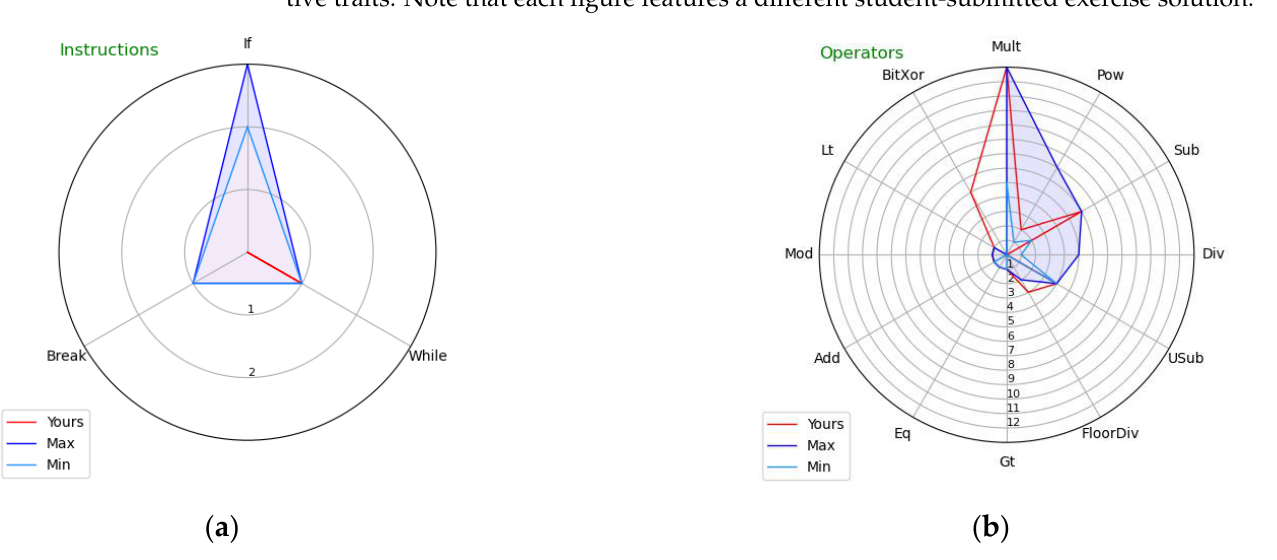
Figure 1. Visual profiles of exemplary students’ programs showing: ( a ) Instructions and ( b ) Operators.